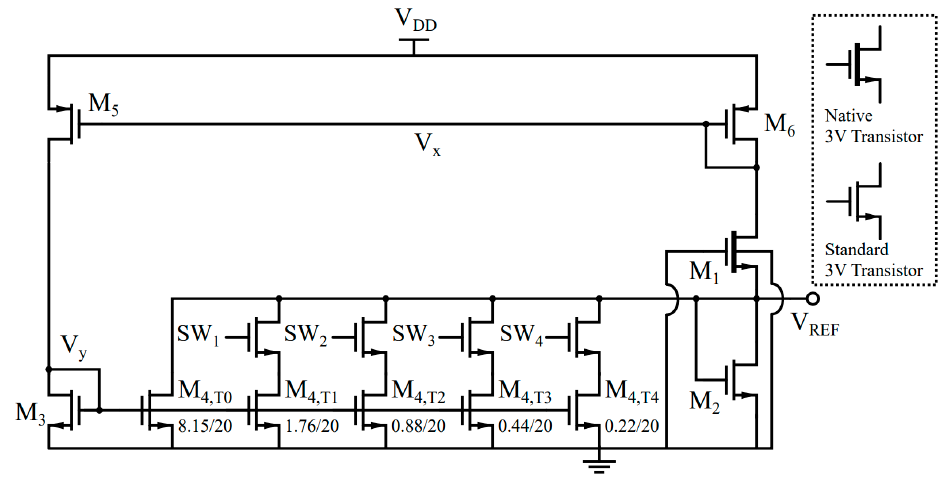
Figure 6. Schematic of the proposed circuit, including trimming for minimum line sensitivity.